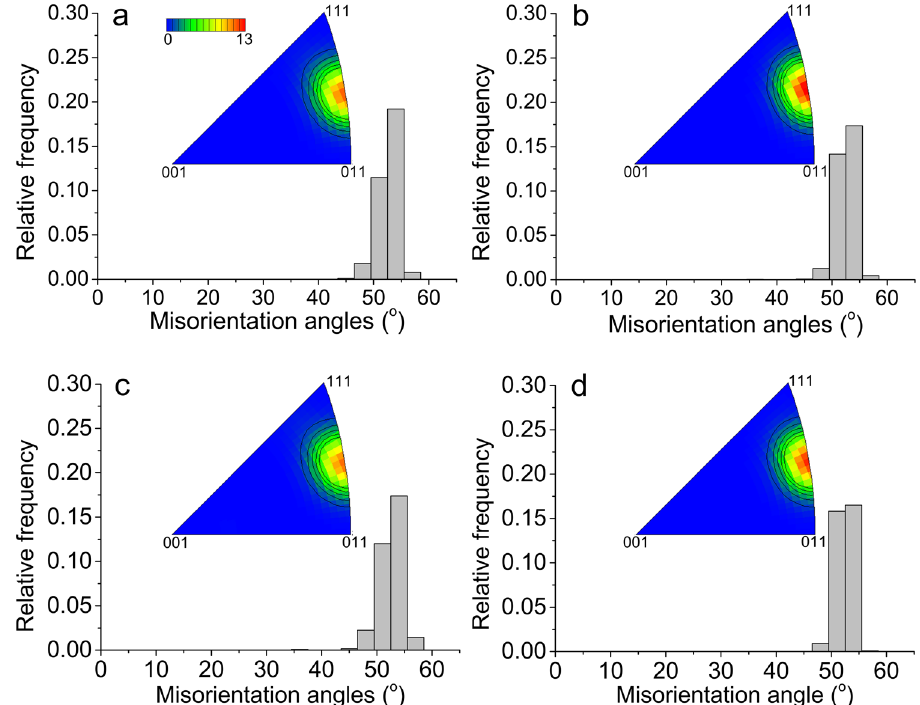
Figure 3. Misorientation distribution for the migrating and non-migrating boundary segments. ( a , b ) and ( c , d ) show data from the first and second annealing steps, respectively. ( a ) and ( c ) are for migrating parts, while ( b ) and ( d ) are for non-migrating parts of the